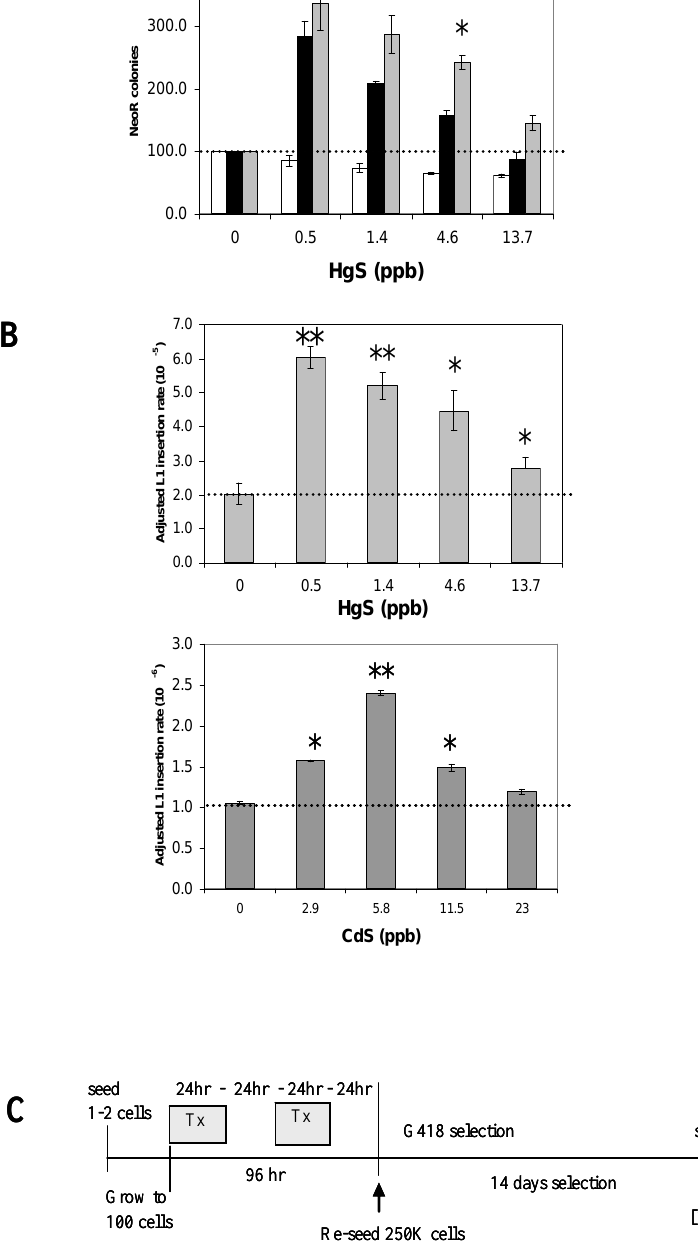
Figure 2: Effect of cadmium and mercury on L1 retrotransposition activity (L1-stable cell line